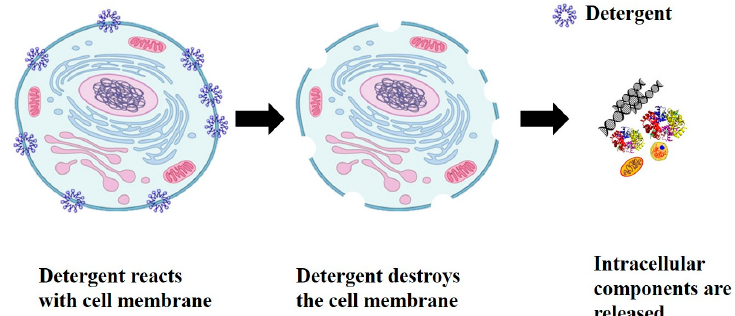
Figure 1. Cell lysis using detergent to open the cell membrane and release the intracellular components. Reproduced with permission from Genomics education program.